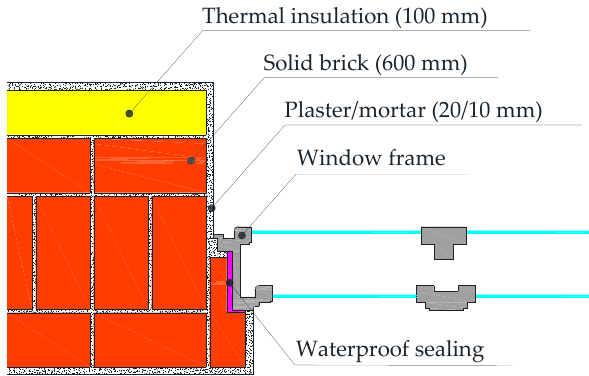
Figure 1. Scheme of the window jamb with the window frame—a horizontal cross-section.